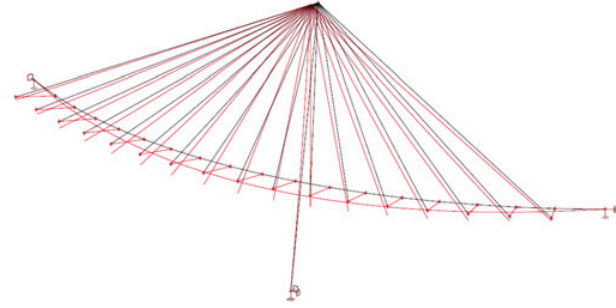
Bending moment on curved deck (P+L): external case